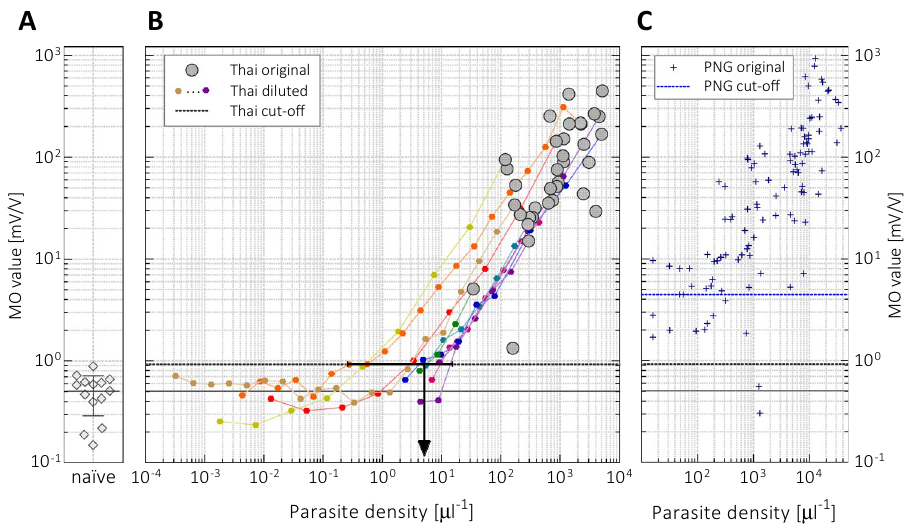
Figure 2. ( A ) The MO values of fourteen malaria-naïve samples obtained from two individuals at various time- points during the course of the study with their mean and standard deviation. ( B ) The MO values of the infected samples (grey circles, n=35) plotted as the function of their parasite densities. Each data point represents the average MO value of at least two technical duplicates (individual errors are below 10% and obscured by the logarithmic scale). The coloured symbols show the MO values of samples obtained by serial dilution of ten infected samples. The black continuous and dashed lines indicate the mean MO value of the malaria-naïve samples and the cut-off level, respectively, while the black arrow marks the estimated lowest detectable parasite density by RMOD. ( C ) The blue asterisks show the MO values of P. vivax -infected samples collected in Papua New Guinea (n = 104), as reproduced from Ref. 15 . The blue dashed line marks the cut-off value for RMOD determined by receiver operating characteristic (ROC) analysis in that study 15